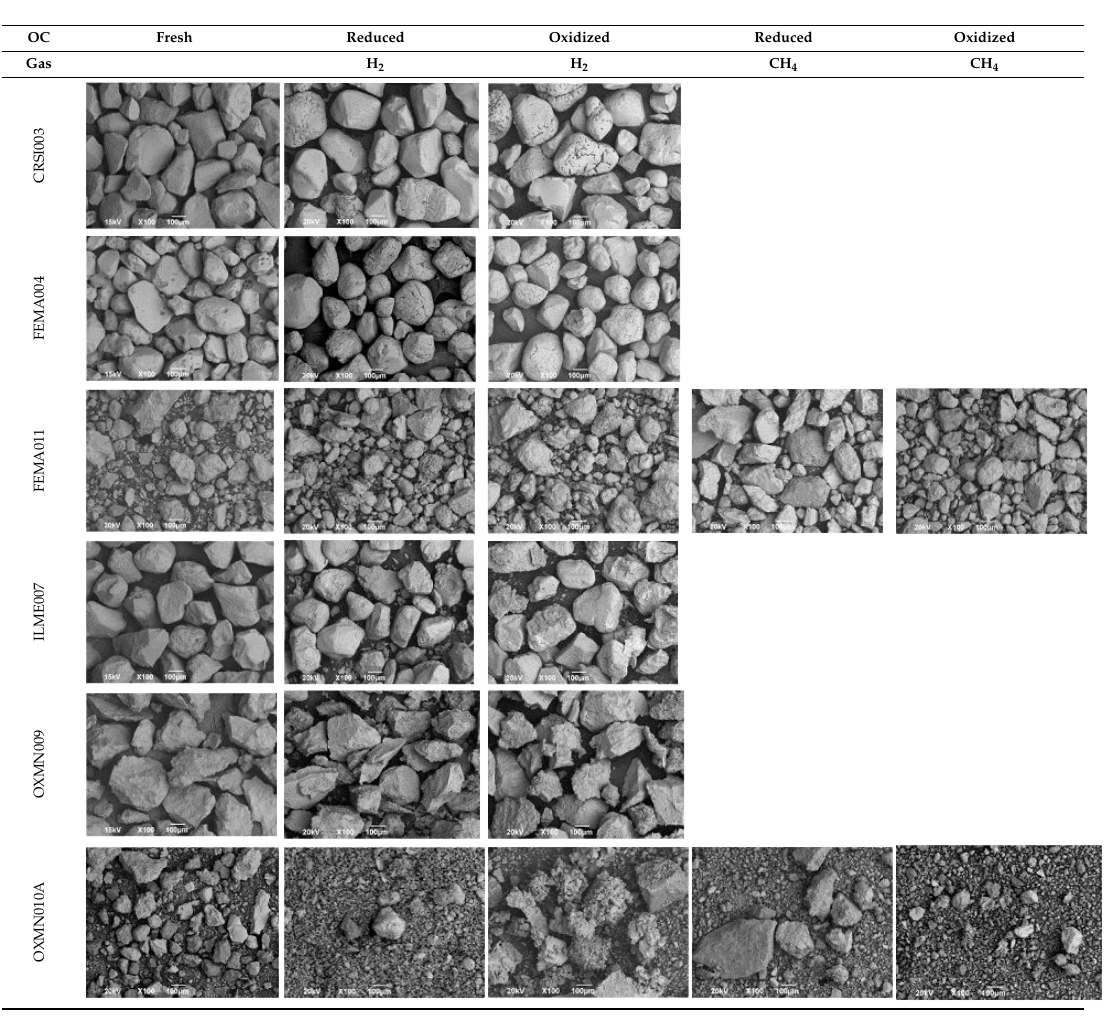
Table 5. SEM results of oxygen